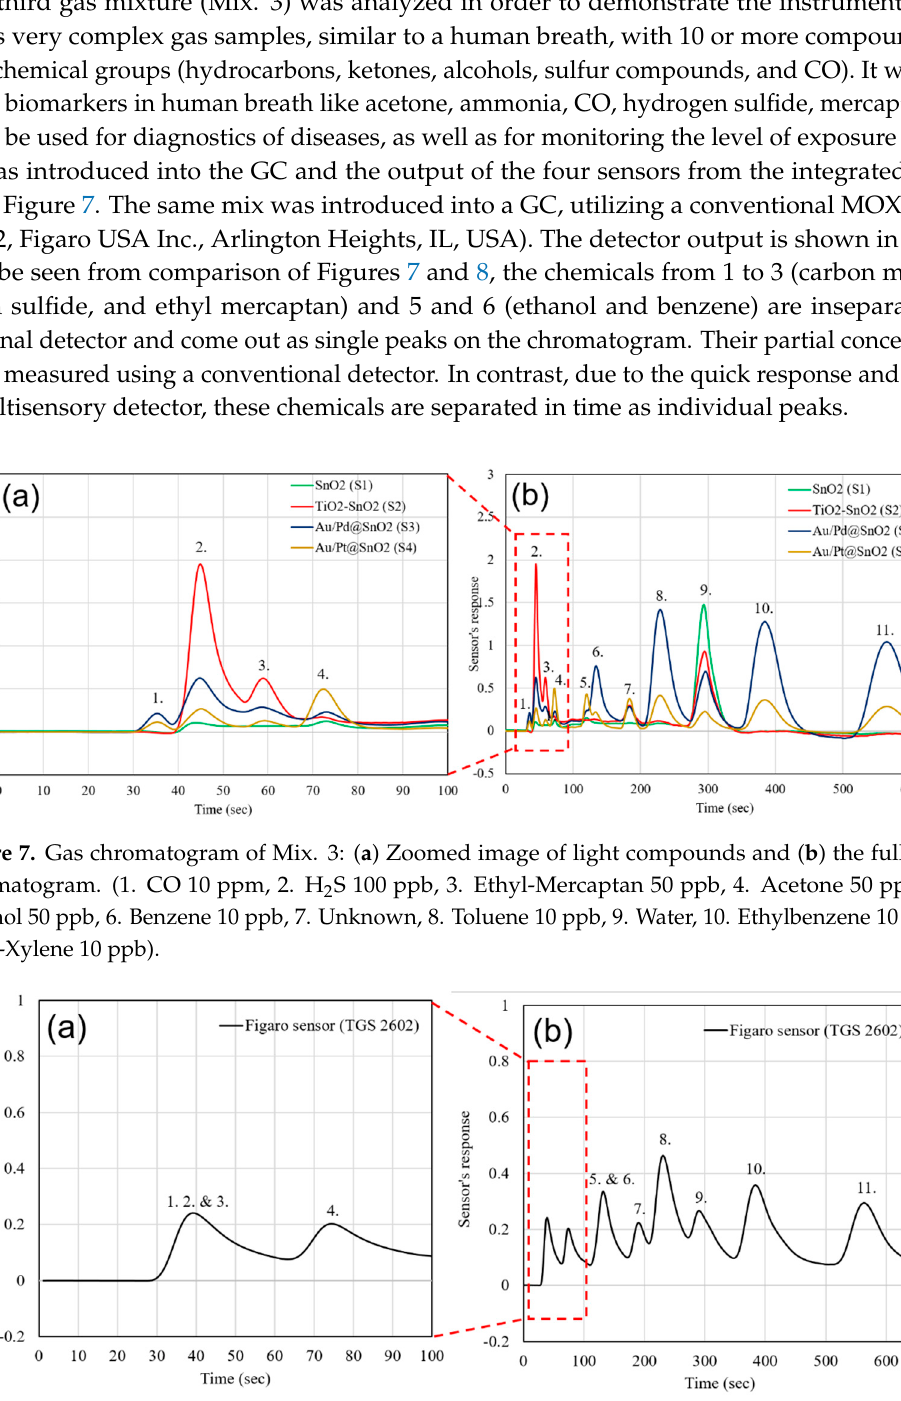
Figure 8. Gas chromatogram of Mix. 3 by using conventional non-selective metal oxide (MOX) detector: ( a ) Zoomed image of light compounds and ( b ) the full gas chromatogram. (1. CO 10 ppm, 2. H 2 S 100 ppb, 3. Ethyl-Mercaptan 50 ppb, 4. Acetone 50 ppb, 5. Ethanol 50 ppb, 6. Benzene 10 ppb, 7. Unknown, 8. Toluene 10 ppb, 9. Water, 10. Ethylbenzene 10 ppb, 11. O-Xylene 10 ppb).